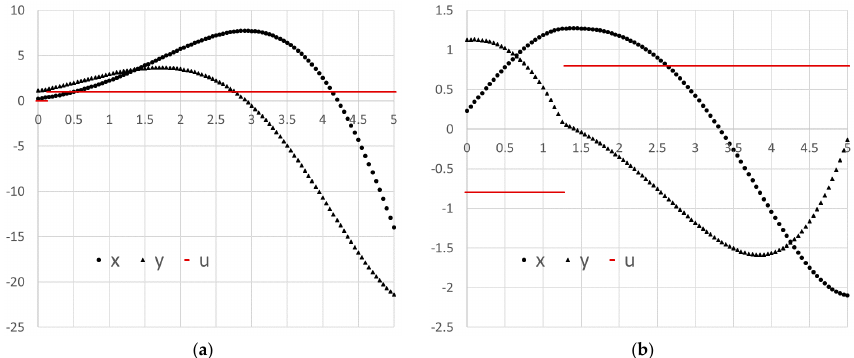
Figure 7. ( a ) Initial trajectories for optimal control problem (6)–(10) based on the default values shown in Figure 3; ( b ) Optimal trajectories found by Excel’s nonlinear programming (NLP) Solver.